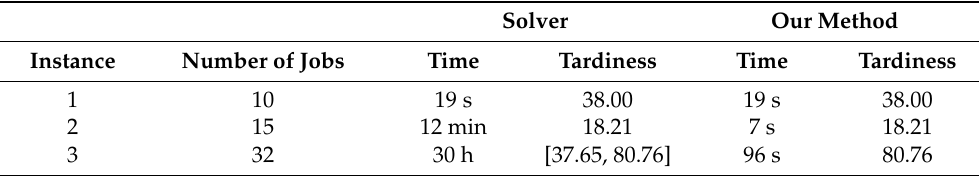
Table 3. Comparison of results between the solver and the hybrid method.